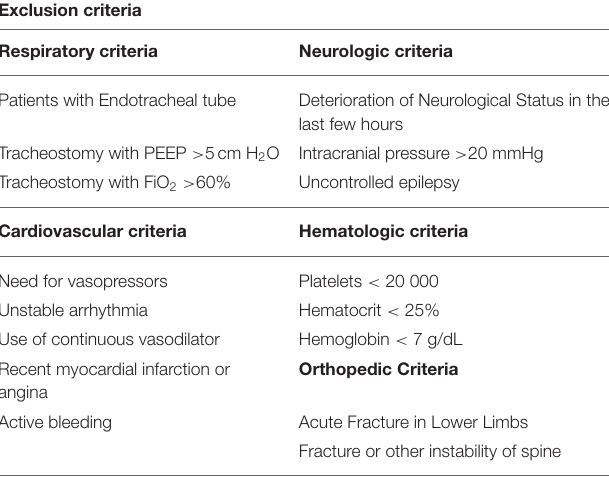
TABLE 1 | Exclusion Criteria for